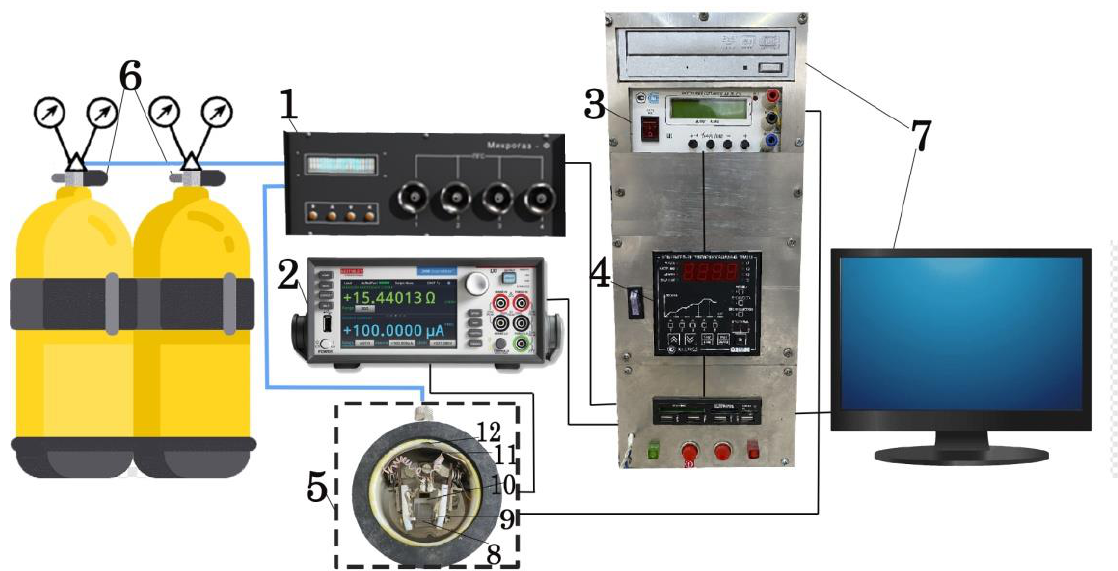
Figure 1. The measuring setup to study the gas-sensing performance of the ZnO-SnO 2 films: 1—a gas mixture generator; 2—a source-meter; 3—a configurator; 4—a power supply; 5—a measuring chamber; 6—calibration gas mixtures at balloons; 7—a personal computer (PC), 8—the sensor sample; 9—probes; 10—a heater; 11—a gas flow divider; 12—a gas supply